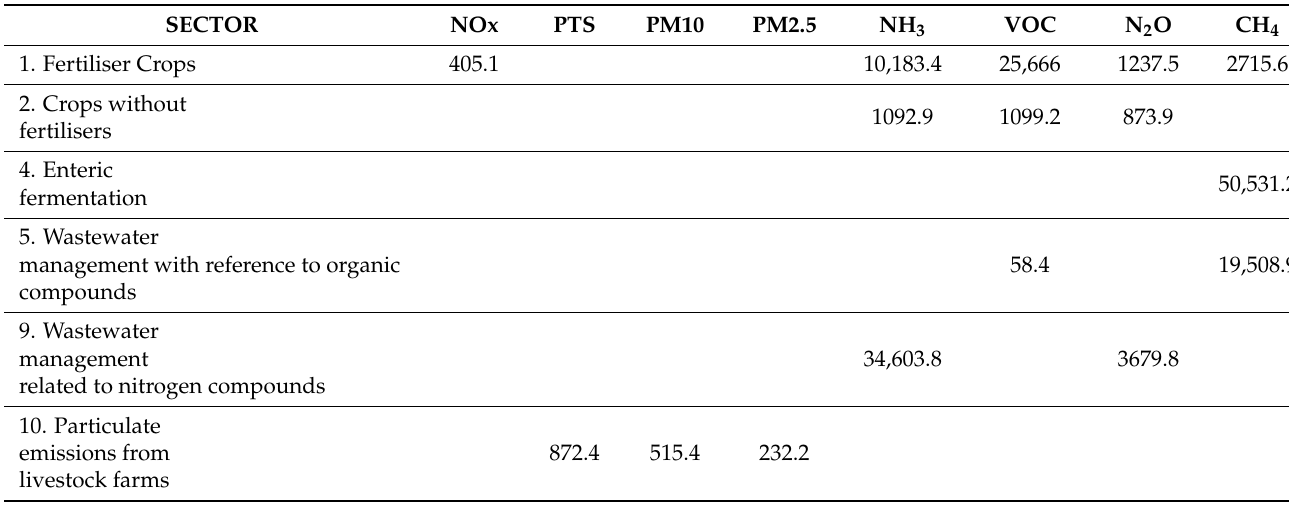
Table 2. INEMAR emissions by sector (expressed in